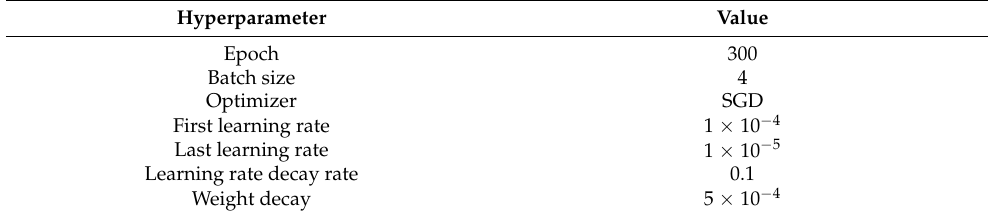
Table 1. Experiment parameter setting.